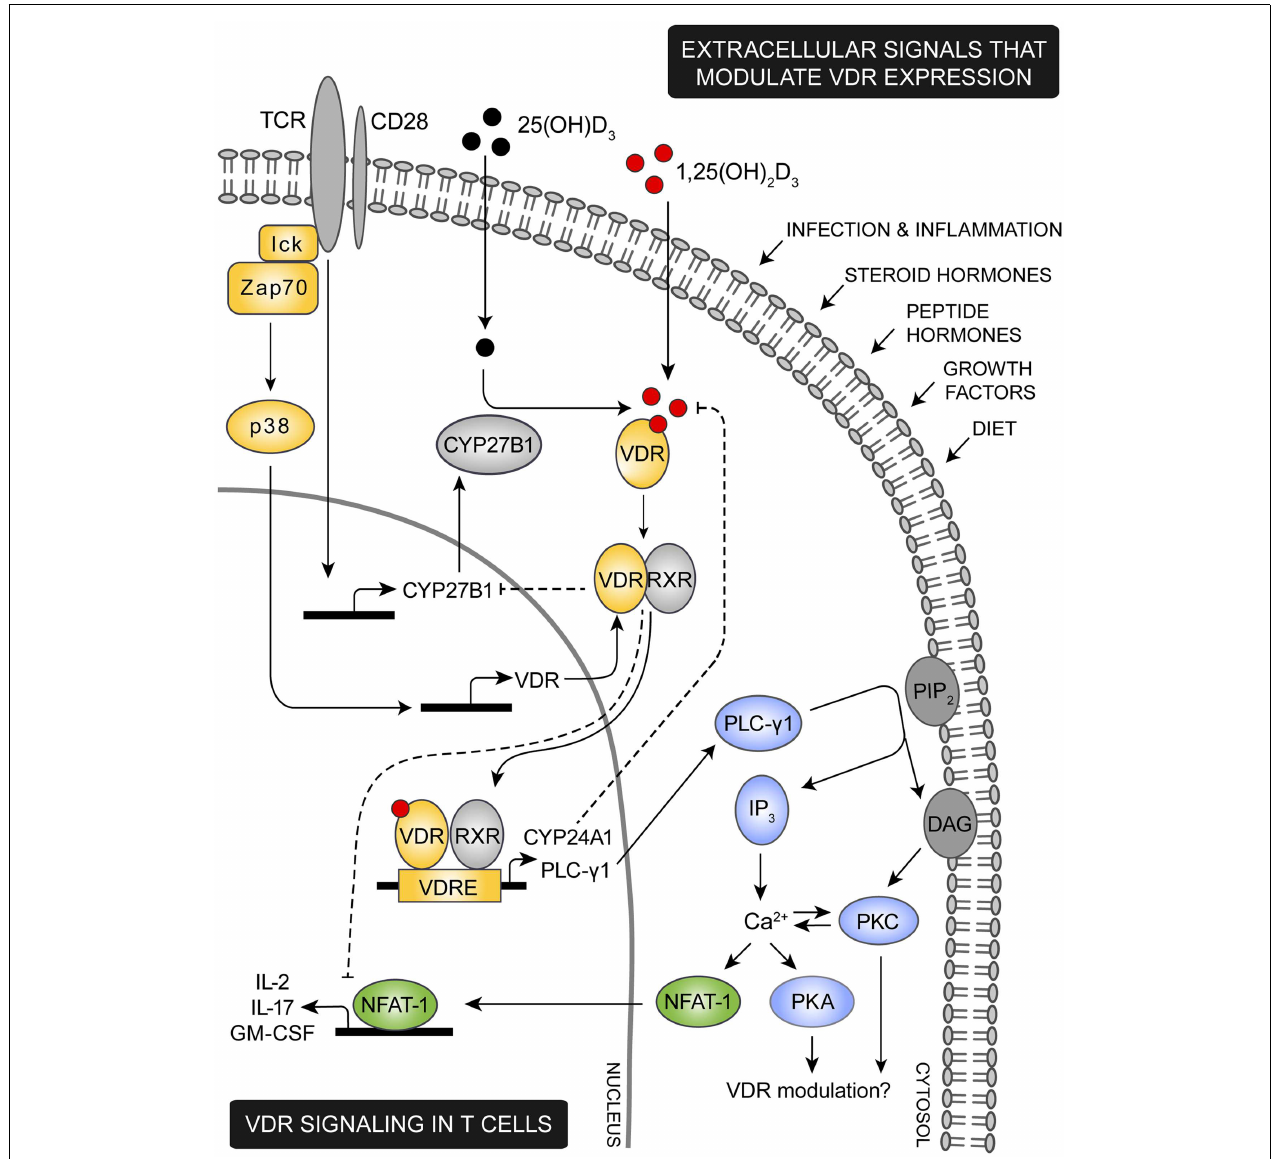
expressed,TCR induced activation of PLC- γ 1 leads to activation of PKA and PKC and an increase in the intracellular calcium level. In other cell types PKA and PKC has been shown to modulate expression ofVDR, depending on the particular cell type and cellular differentiation state investigated. An increase in intracellular calcium concentration activates NFAT1 a necessary transcription factor for expression of IL-2 and other cytokines. IL-2 is a cytokine required for proliferation ofT cells and one mechanism by whichVDR adjustT cell activity is to outcompete NFAT1’s binding to the IL-2 promoter and furthermore to down-regulate the actual expression of NFAT1.To controlVDR activity a series of negative feedback loops exists; activatedVDR both induce expression of the 1,25(OH) 2 D 3 degrading enzyme CYP24A1 and down-regulates expression of the 1,25(OH) 2 D 3 synthesizing enzyme